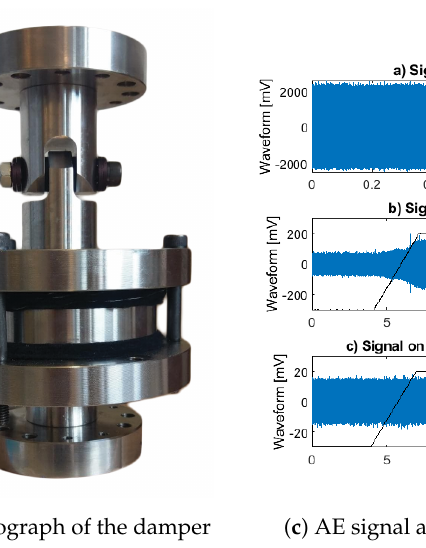
Figure 2. Clevis damper